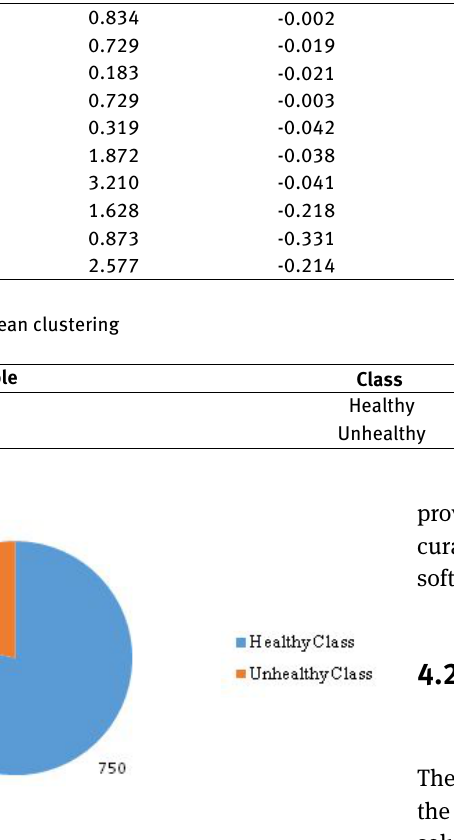
Figure 10: Quantity of healthy and unhealthy class